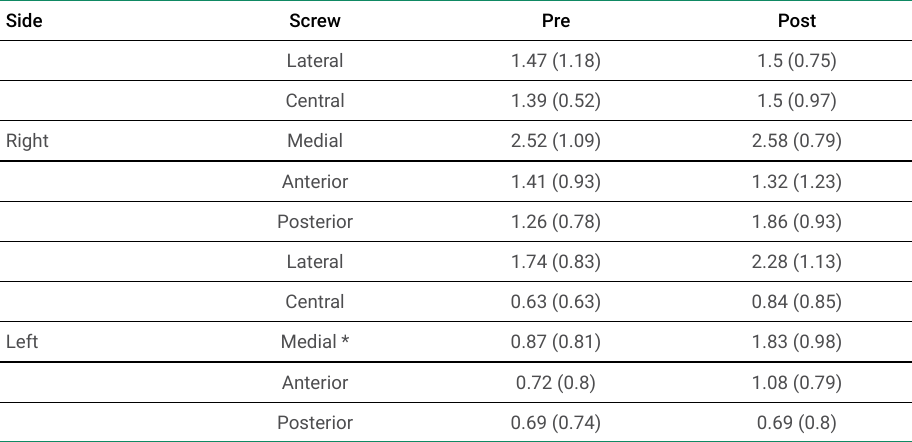
Table 1. Averages, standard deviation (SD) and statistical test result of the distances between the screws at the glenoid fossa and mandibular condyle in the preoperative and postoperative periods of both sides. *Significant (p <0.05).